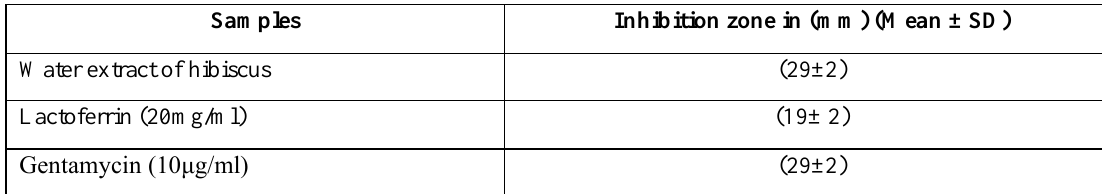
Table 4. Inhibition zone (mm) of lactoferrin and hibiscus against Pantoea spp.